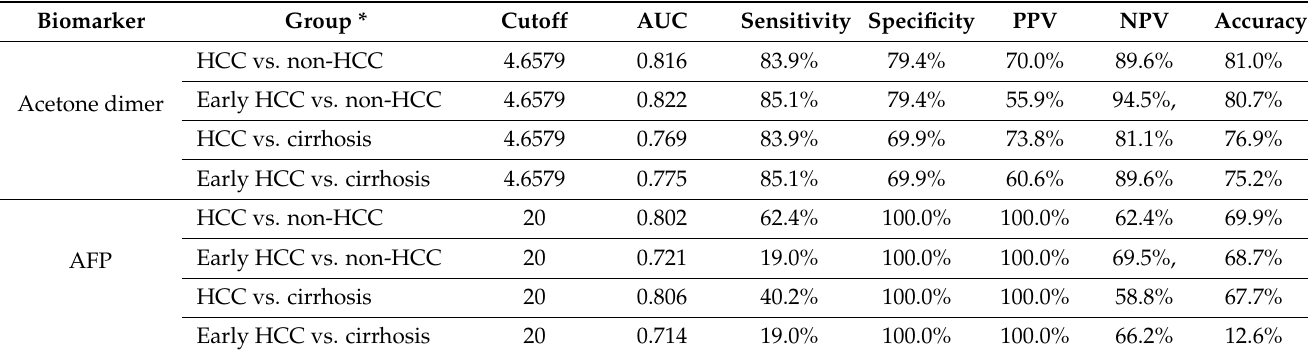
Table 3. Performance of acetone dimer and alpha fetoprotein for diagnosis of